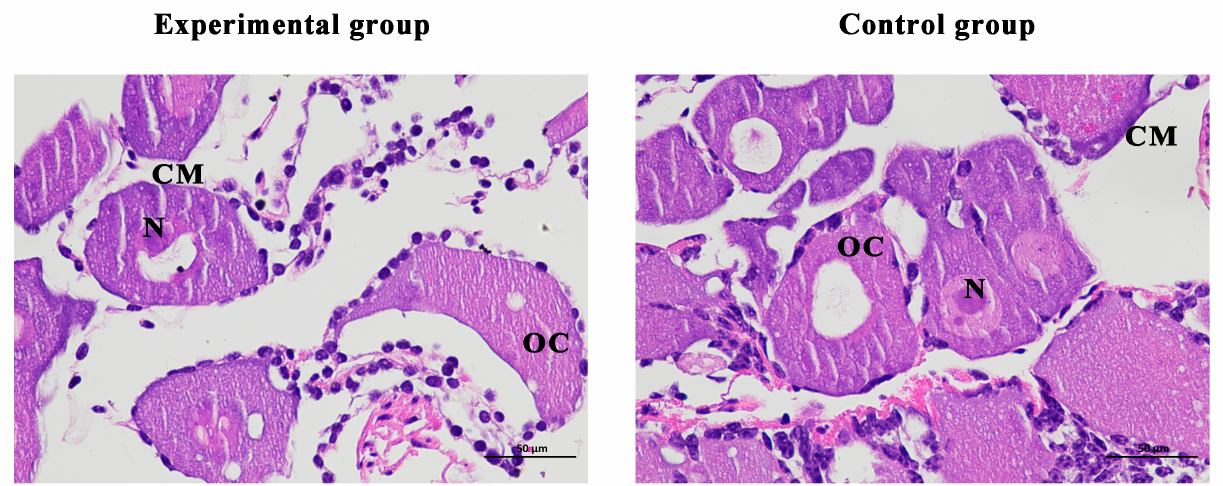
Figure 9. Histological observation of ovary of Macrobrachium nipponense after injection with Mn-CH7D dsRNA. OC: oocyte; N: nucleus; CM: cytoplasmic membrane; Scale bars: 400×.